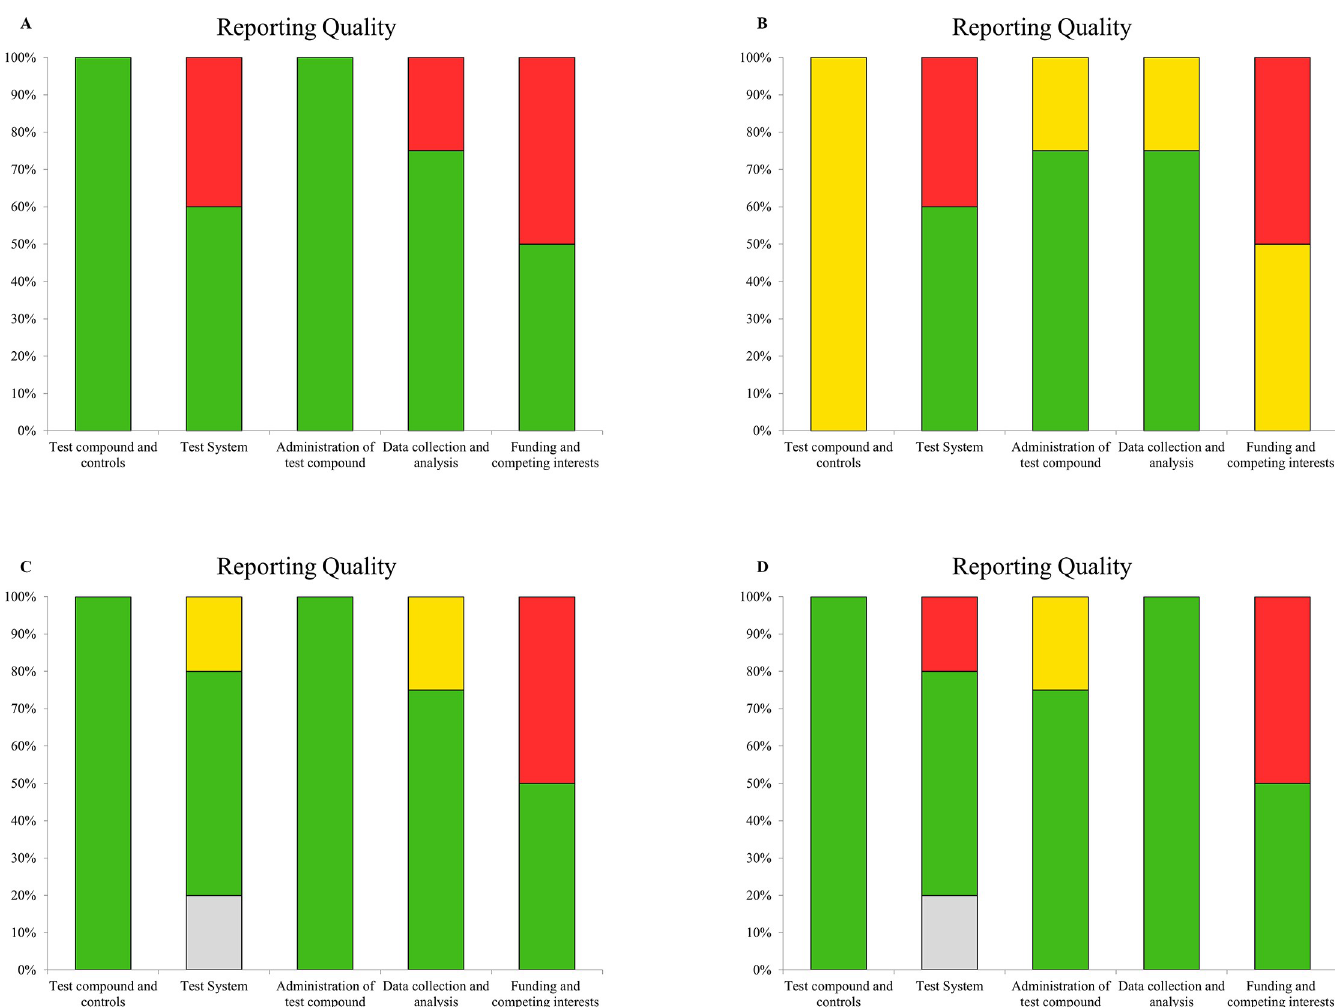
Fig 2. Reporting quality in in vitro studies. A. L . ferrea fruits quality reporting on in vitro study. B. L . ferrea leaves quality reporting on in vitro study. C and D. L . ferrea s tem bark quality reporting on in vitro study. Grey: not determined; green bar: fulfilled; yellow bar: partially fulfilled; red bar: not